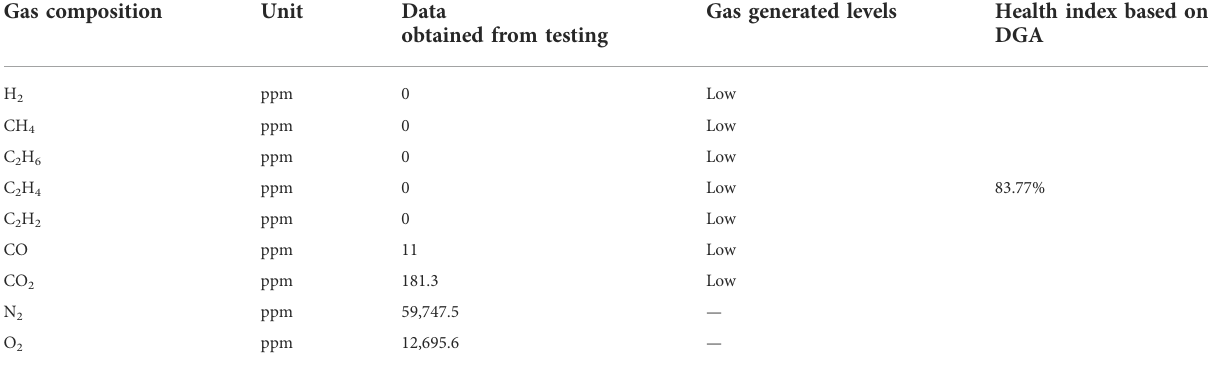
TABLE 2 Health index based on dissolved gas